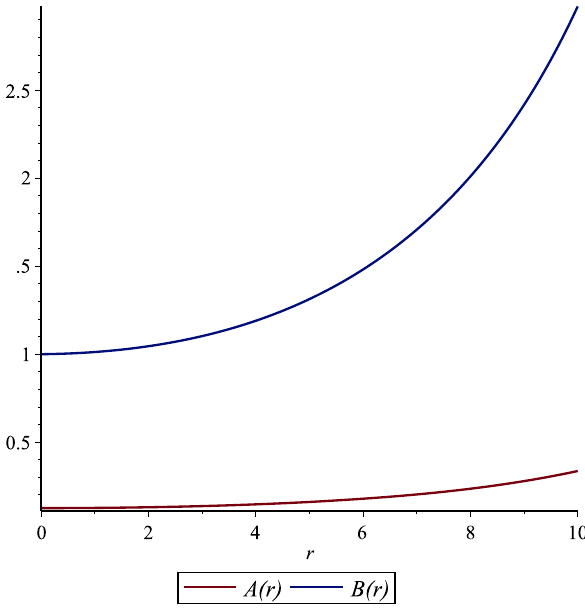
Fig. 1 Behavior of the metric potentials A ( r ) and B ( r ) versus r